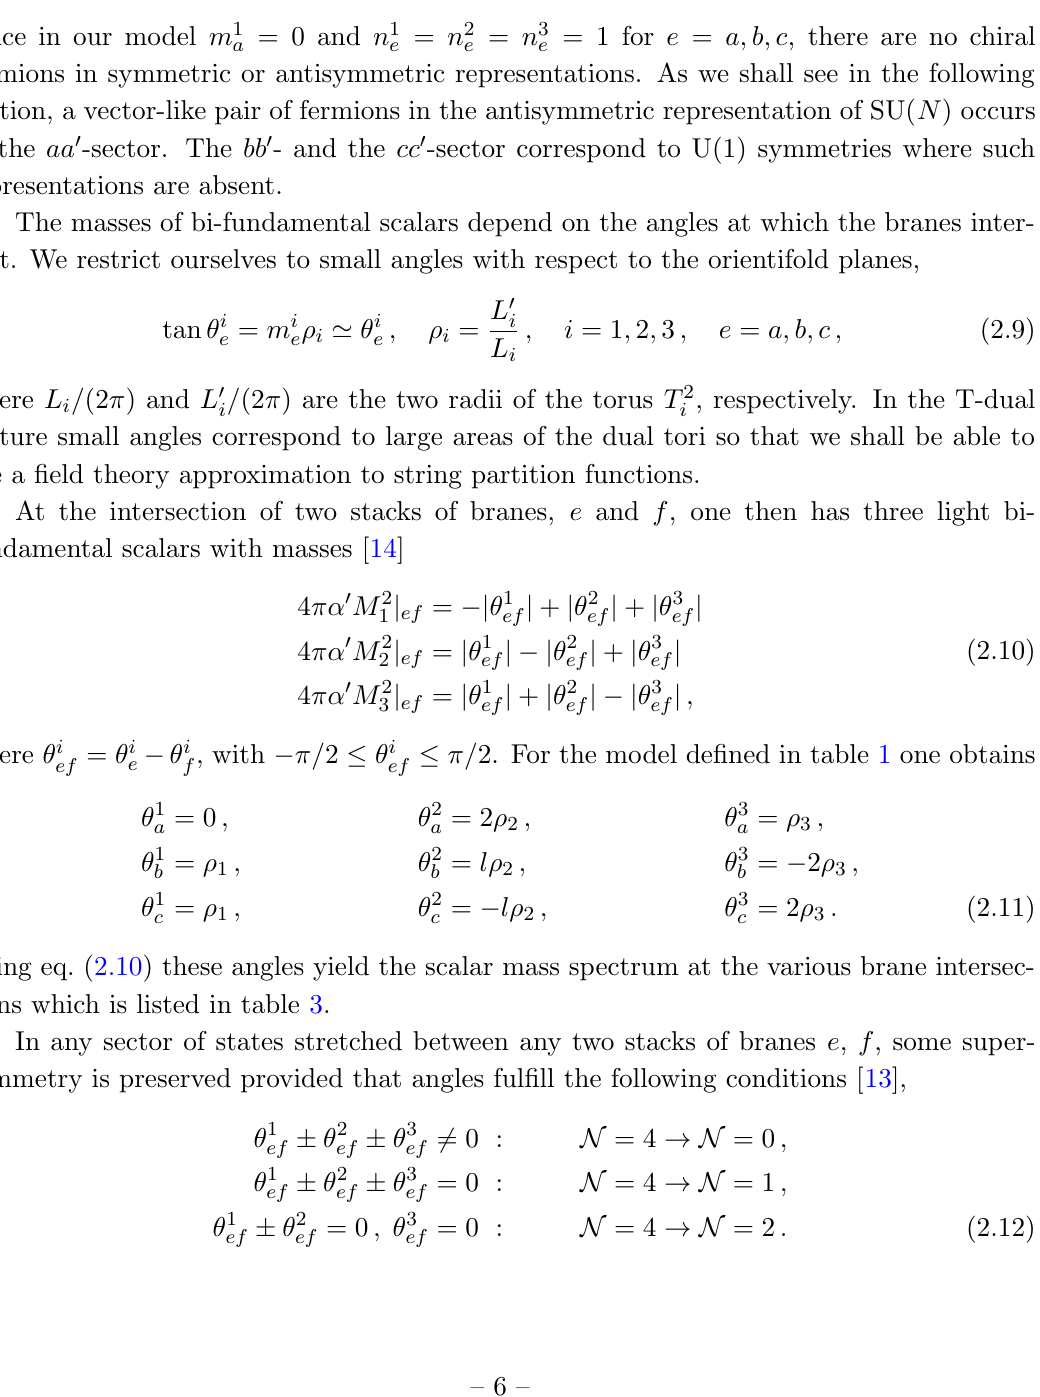
Table 3 . Masses of scalars at various brane